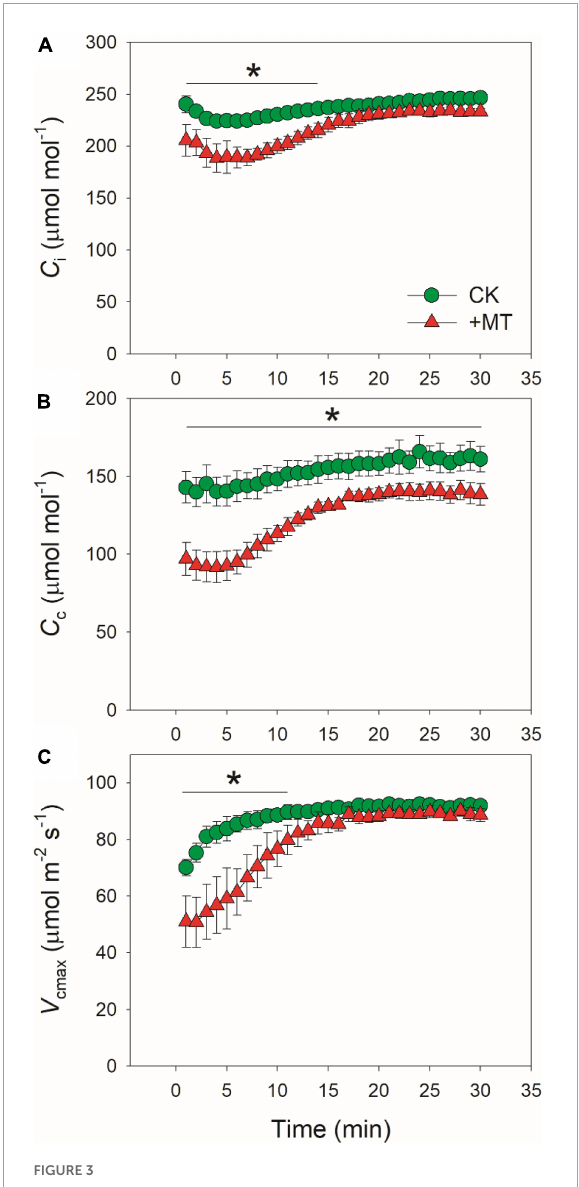
FIGURE3 Effects of exogenous melatonin (MT, 100 µ M) on the induction response of intercellular CO 2 concentration [Ci, (A) ], chloroplast CO 2 concentration [Cc, (B) ], and the maximum velocity of Rubisco for carboxylation [Vcmax, (C) ] after transition from 50 to 1500¸tmol photons m − 2 s − 1 . Values are means ± SE ( n = 5). Asterisk indicates a significant difference between CK and MT-treated